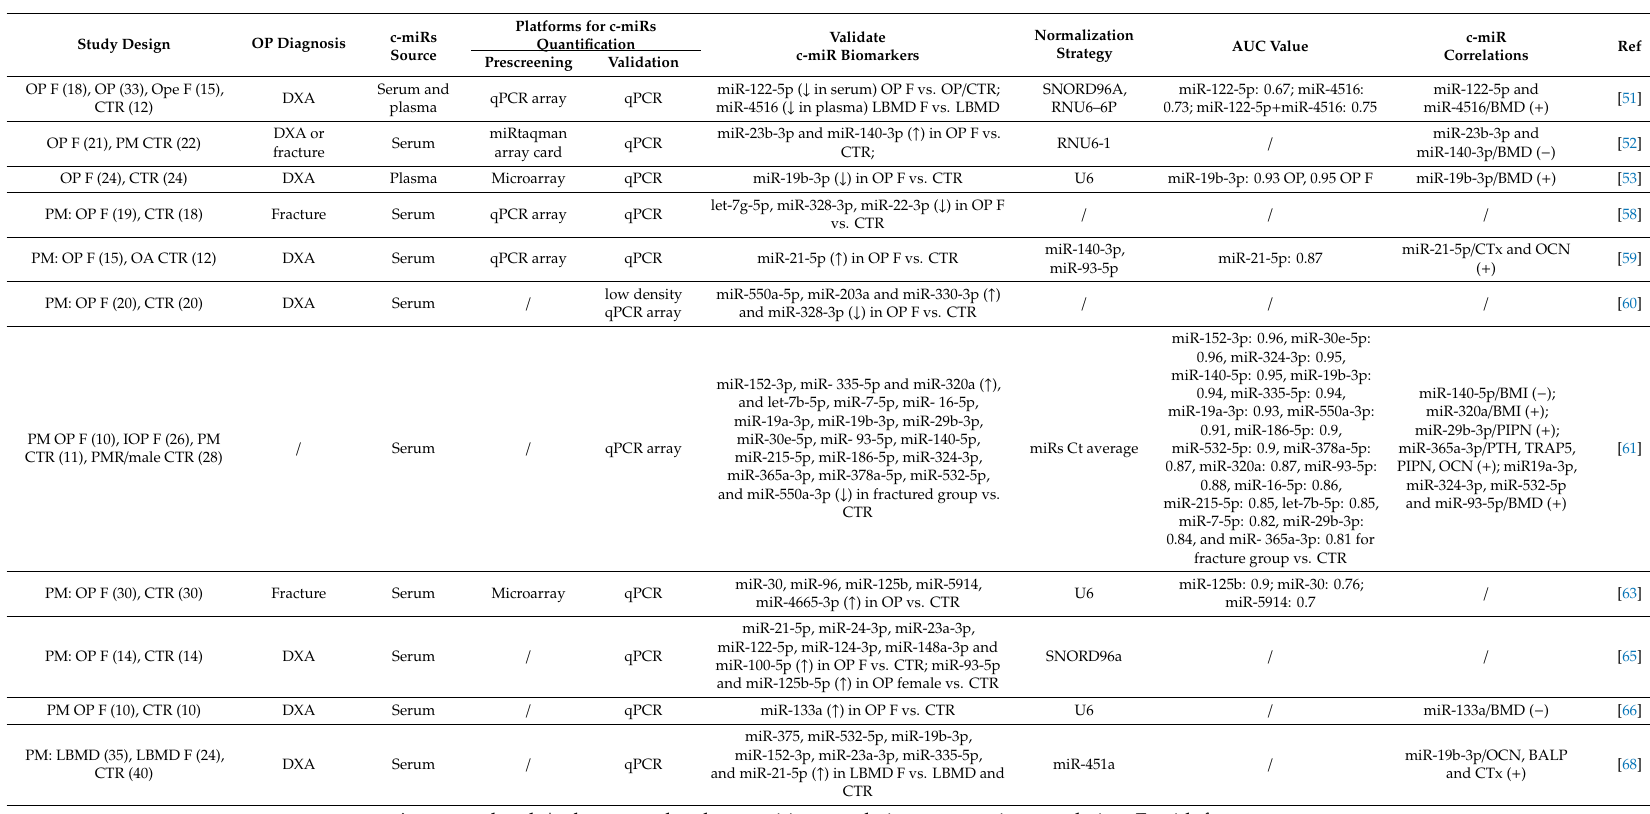
Table 2. Overview of studies that evaluated c-miRs to distinguish OP / Ope patients with fragility fracture (wF) from normal bone mass controls (CTRs) woF.